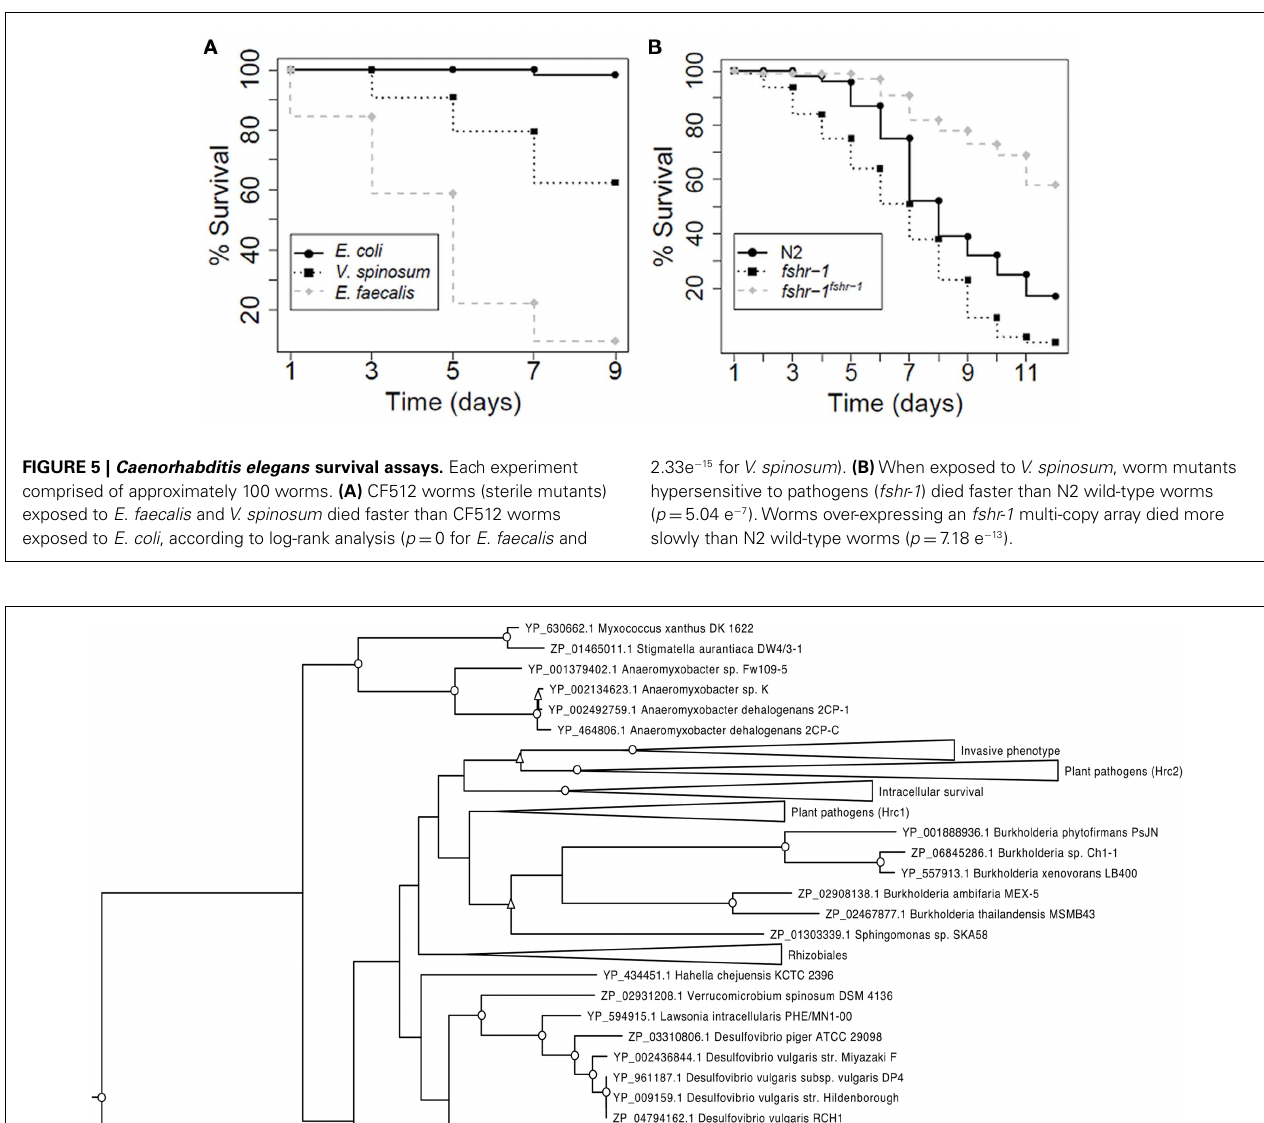
clades indicateT3SS classes as described byTroisfontaines and Cornelis (2005). Hrc1 and Hrc2 plant pathogen groups; intracellular survival; invasive phenotype; Chlamydiales T3SS family (intracellular life-style); extracellular pathogen life-style, resistance to phagocytosis, and triggering of apoptosis in macrophages; Rhizobiales T3SS family (symbiotic relations with leguminous plants). Open clusters contain at least one “free-living” organism.